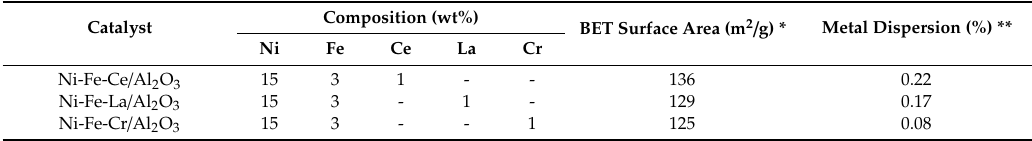
Table 6. Physicochemical properties of the prepared Ni-based Fe promoted catalysts [85] (used with copyright permission).